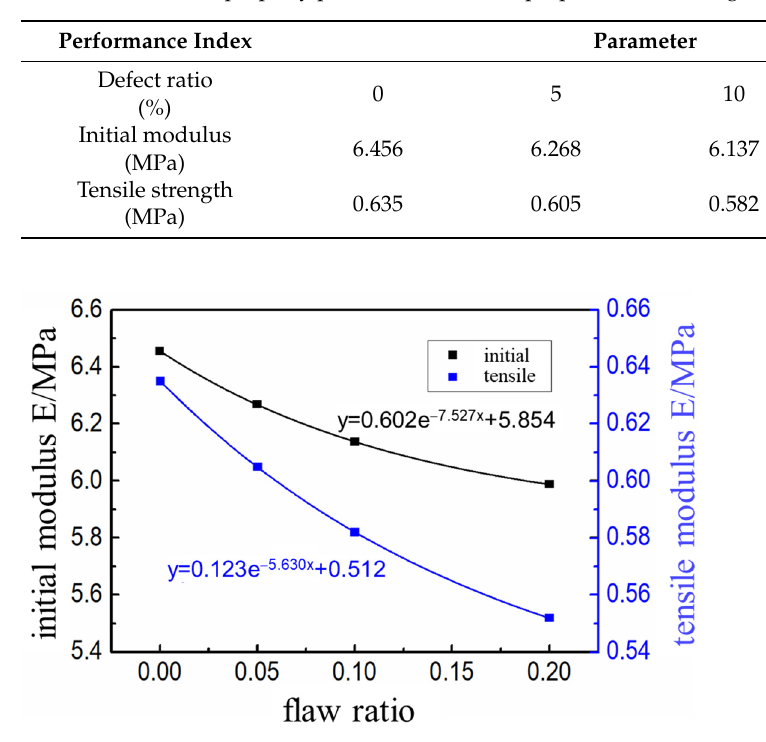
Figure 10. The variation of initial modulus and tensile strength with the interface defect content.